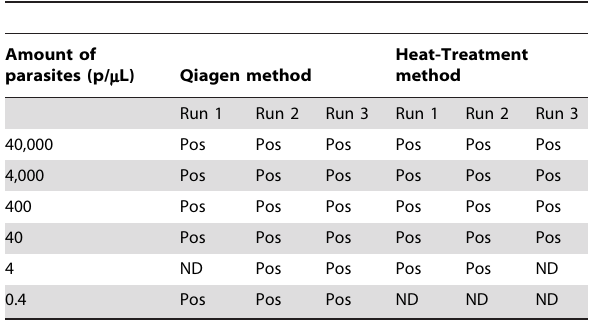
Table 3. Amplification of Plasmodium falciparum from heat treated blood samples.